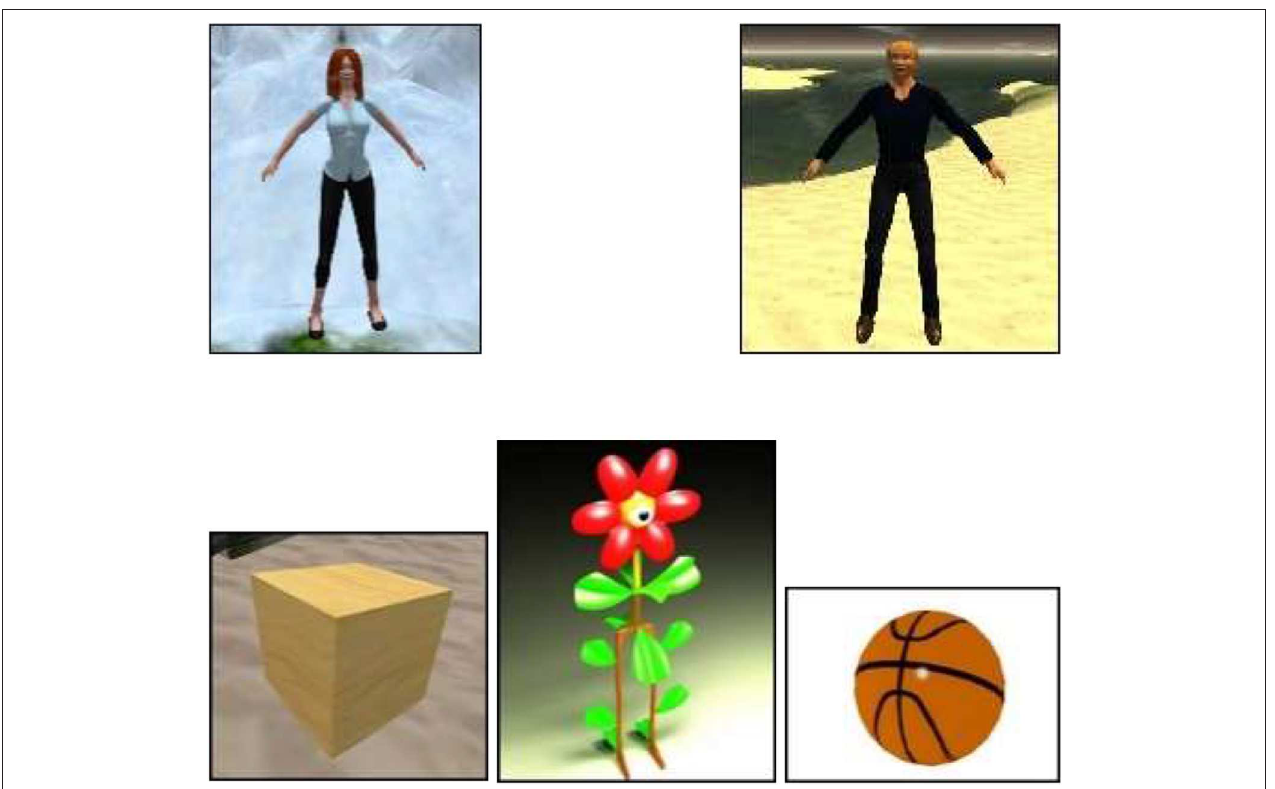
FIGURE 1 | Second Life avatars used in the study. Line 1, anthropomorphic avatars (female and male); Line 2, non-anthropomorphic avatars (cube, flower, and balloon).